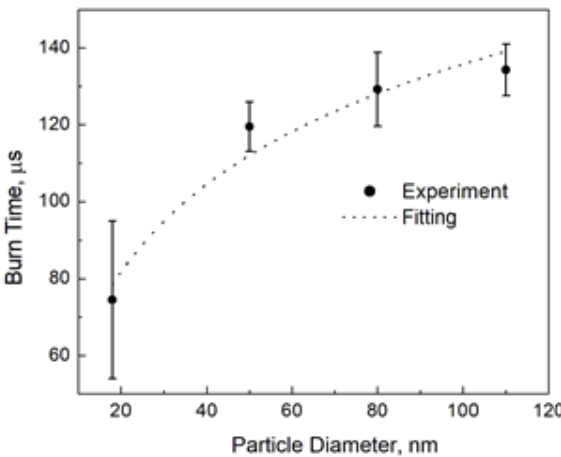
Figure 3. The burn time of aluminum nanoparticles [1] and fitting to the logarithmic law, Equation (6), with t 0 = 35 µs and d * = 2.2 nm.